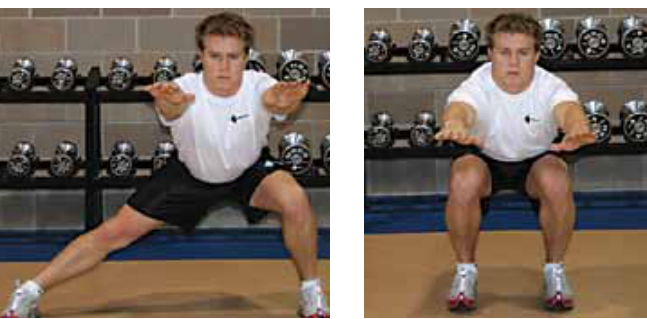
Figure 5-10a. Side Lunge Position Figure 5-10b. Squat